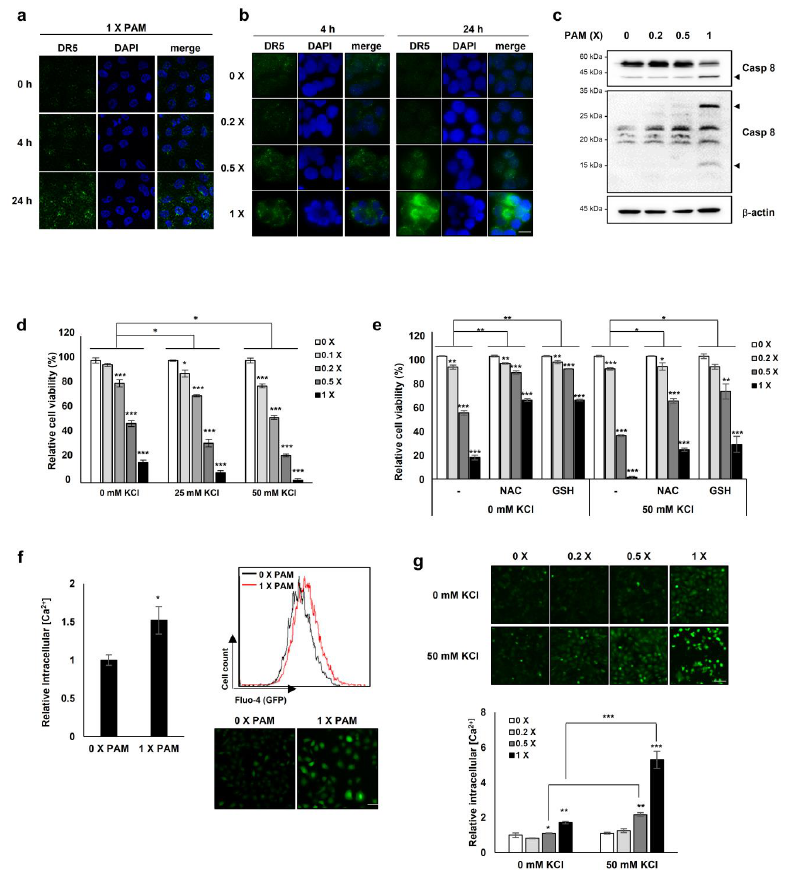
Figure 4. PAM promotes membrane-bound DR5 redistribution. HeLa cervical cancer cells ( a ) and HT-29 colorectal cancer cells ( b ) were treated with serially diluted PAM for 4 or 24 h. Original magnification: × 630. Scale bar: 10 μm. After PAM treatment, cells were fixed with 4% paraformaldehyde for 15 min followed by immunostaining with anti-DR5 antibody. DR5 clustering was detected by fluorescence microscopy. ( c ) HeLa cells were treated with PAM for 24 h, as indicated. Caspase 8 protein levels were determined by immunoblotting. β-actin was used as a loading control. Arrow head: cleaved form of caspase 8. ( d ) The effects of PAM on A549 cancer cells. A549 lung cancer cells were treated with serially diluted PAM supplemented with 0, 25, or 50 mM KCl for 24 h. Cell viability was measured using the MTT assay. ( e ) The antioxidants, N-acetyl-cysteine (NAC), and reduced glutathione (GSH) abrogate the impaired ion homeostasis induced by PAM. A549 cells were treated with serially diluted PAM in the absence or presence of 50 mM KCl supplemented with 2 mM NAC or 1 mM GSH for 24 h. ( f ) Intracellular concentration of Ca 2 + was measured following PAM treatment of A549 cells. After incubation with 2 µ M Fluo-4, AM for 45 min, intracellular Ca 2 + concentration was analyzed by FACS analysis or by fluorescence microscopy. Scale bar: 50 µ m. ( g ) U2OS cells were treated with serially diluted PAM in the absence or presence of 50 mM KCl for 24 h, and then the level of intracellular Ca 2 + was evaluated. * p < 0.05, ** p < 0.01, *** p < 0.001. Scale bar: 50 µ